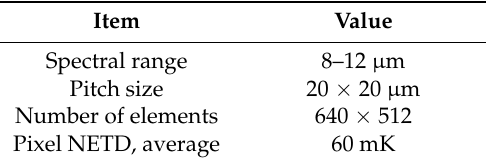
Figure 4. LW 640 × 512 un-cooled IR detector. Table 1. Detector characteristics.